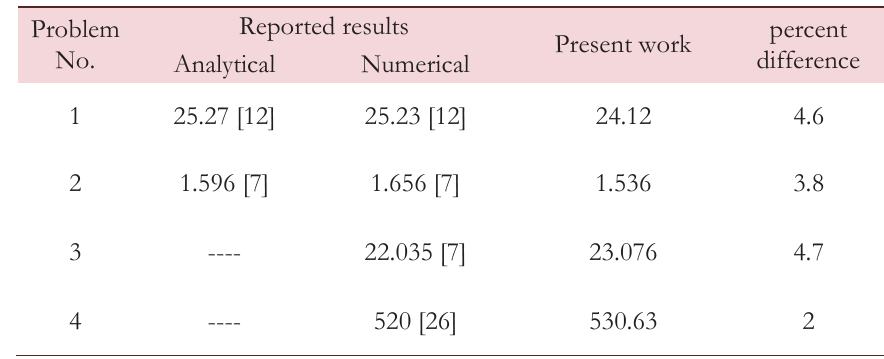
Table 1: Comparison of K I values obtained by numerical simulation with those reported in the literature. It seems that the obtained results based on the XFEM method agree very well with that reported in the